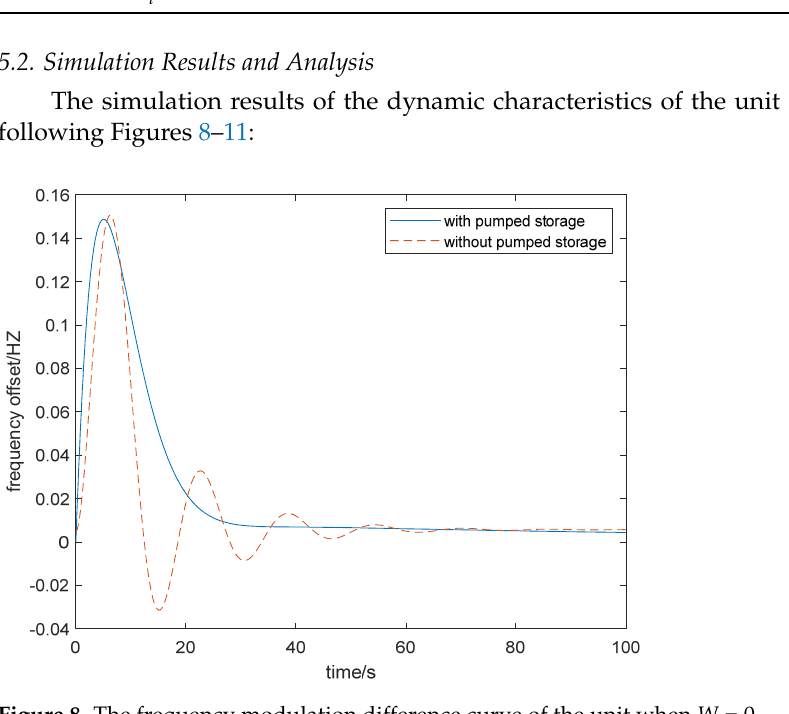
Figure 8. The frequency modulation difference curve of the unit when W = 0.